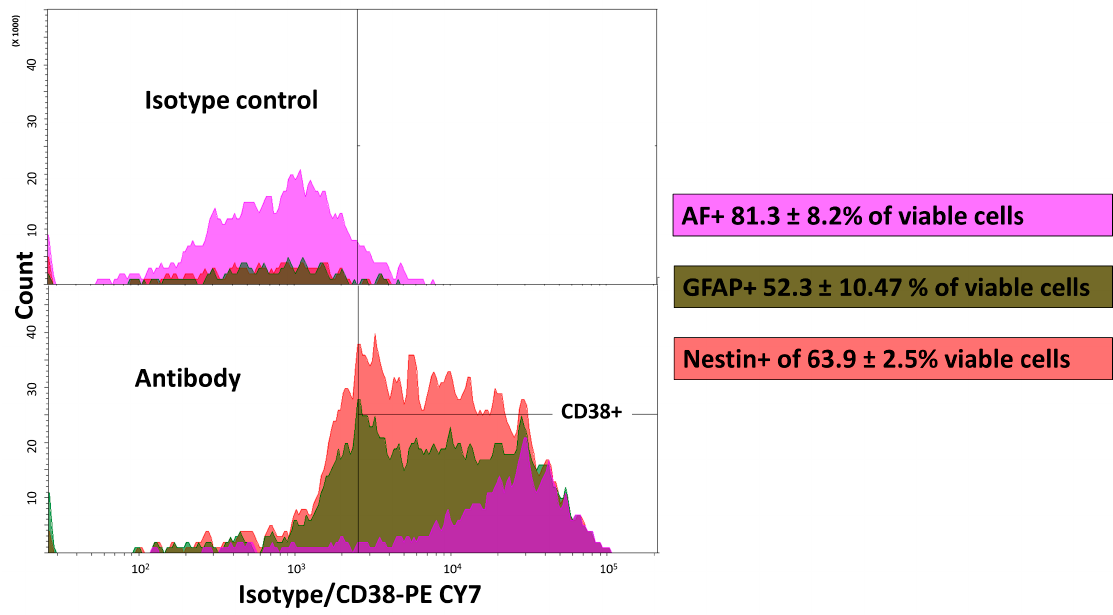
Figure 5. The CD38+ cell population expresses hepatic stellate cell specific intracellular markers GFAP and Nestin. CD38 expression of backgated GFAP+ Nestin+ and violet-induced (AF)+ populations after isotype control (upper panel) and antibody (lower panel) directed against CD38. It appeared that the majority of CD38+ cells were positive for Nestin and GFAP and autofluorescent. Proportions (of viable cells) are expressed as a mean ± SD, n =